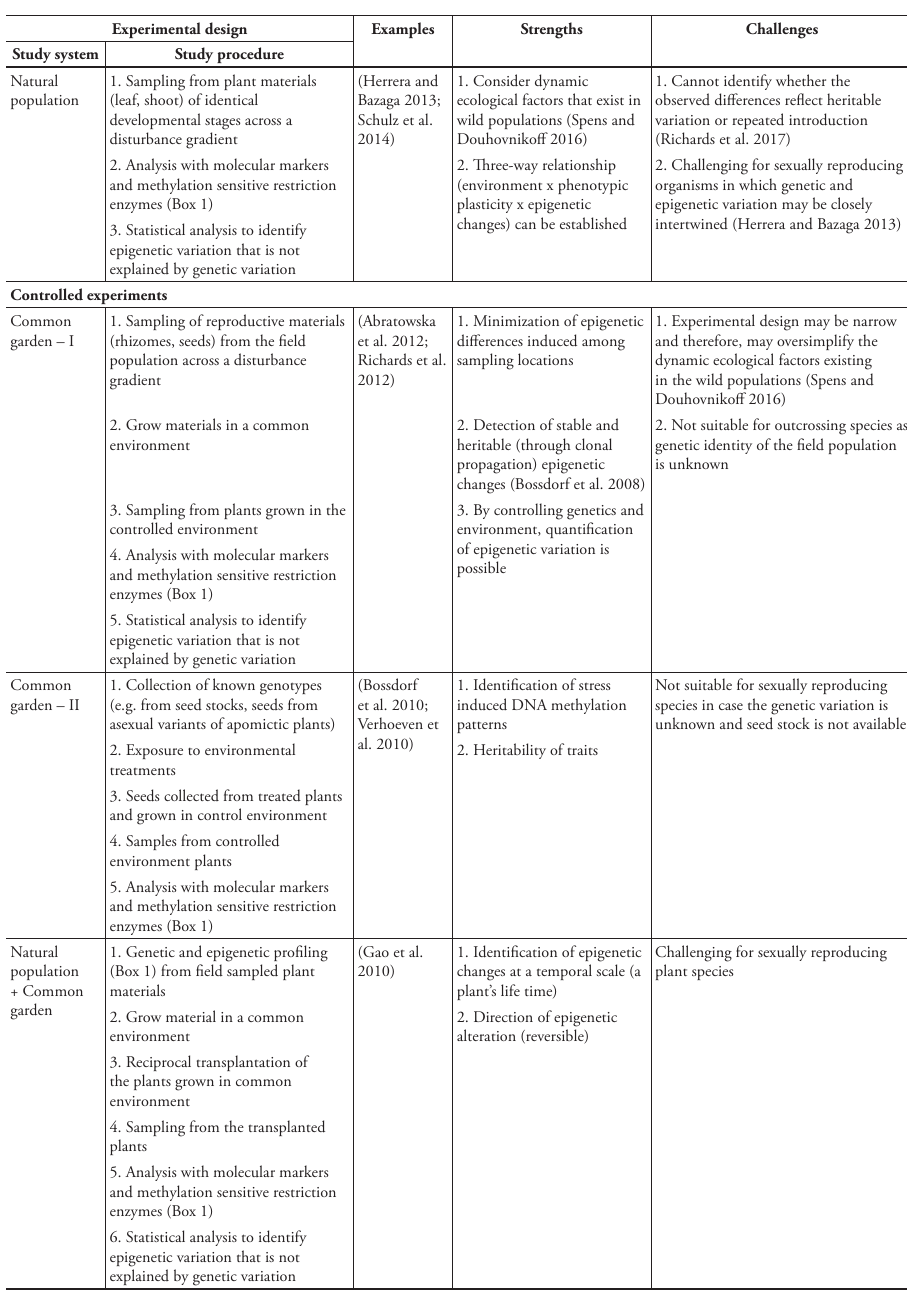
Table 2. Experimental designs commonly used for investigating the effect of epigenetic variation on phenotypic plasticity and transgenerational pattern of epigenetic changes across generations. Strengths and challenges associated with each of these approaches have been